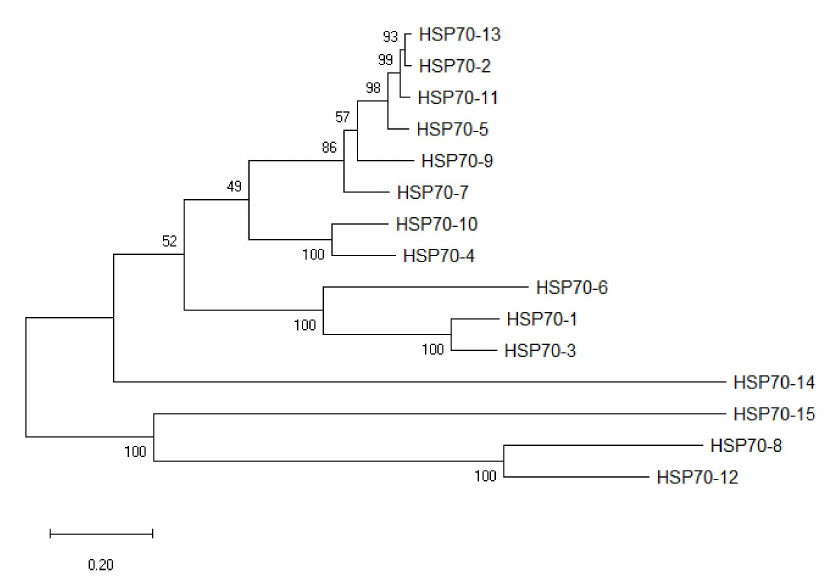
Figure 1. Phylogenetic tree of AsHSP70s in A. sinensis . Fifteen AsHSP70 members were identified from the genome in A. sinensis . Unrooted phylogenetic tree was constructed based on multiply- aligned sequences of the 15 AsHSP70 proteins with 1000 bootstrap replications.